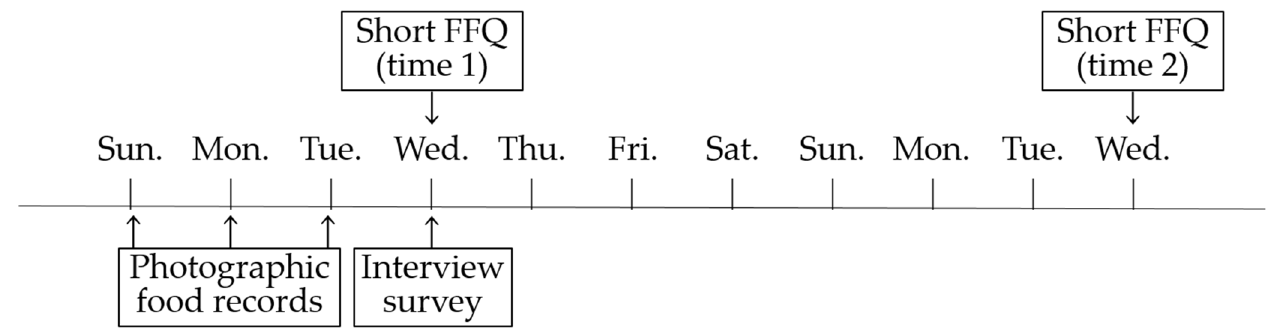
Figure 1. Schedule of the validation study.